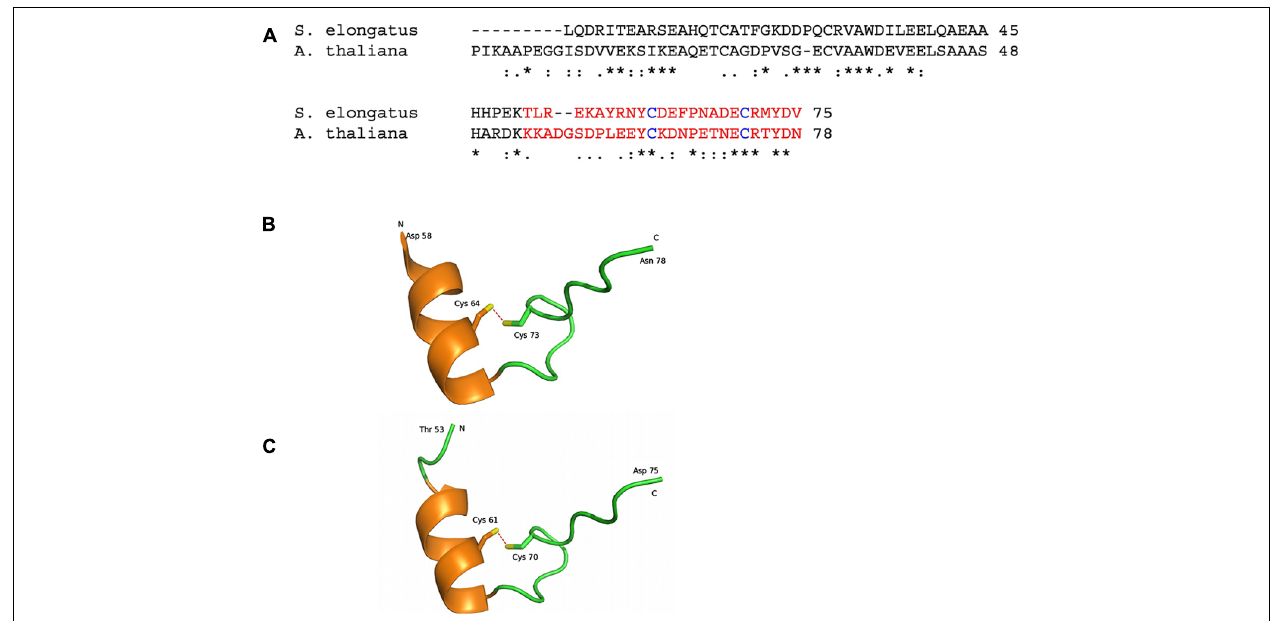
resolution crystal structure of the C-terminal region of CP12 from S. elongatus (Matsumura etal., 2011; PDB accession code 3b1j). Each structure contains a single alpha helix and a disulphide bond (red dashed lines). N and C represent the ends of the structured region, with the remaining amino acids being disordered and not modeled. Conserved amino acid residues are denoted by (*); conservative changes (:) and semi-conservative